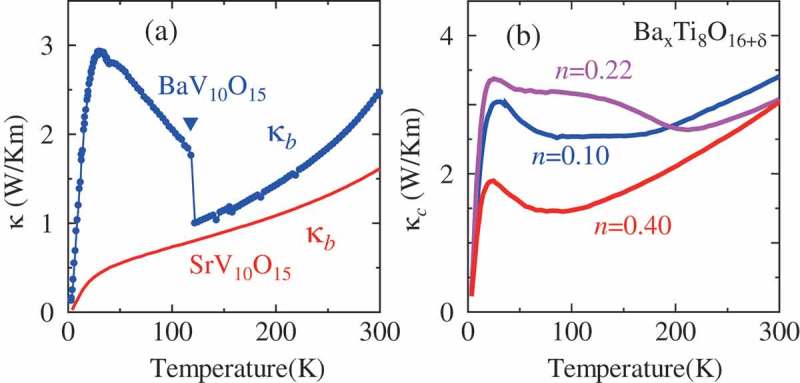
(a)(b) Temperature dependence of the thermal conductivity for (a) BaV10O15 and SrV10O15 and (b) BaTi8O16+δ. Reproduced with permission from [11,29].